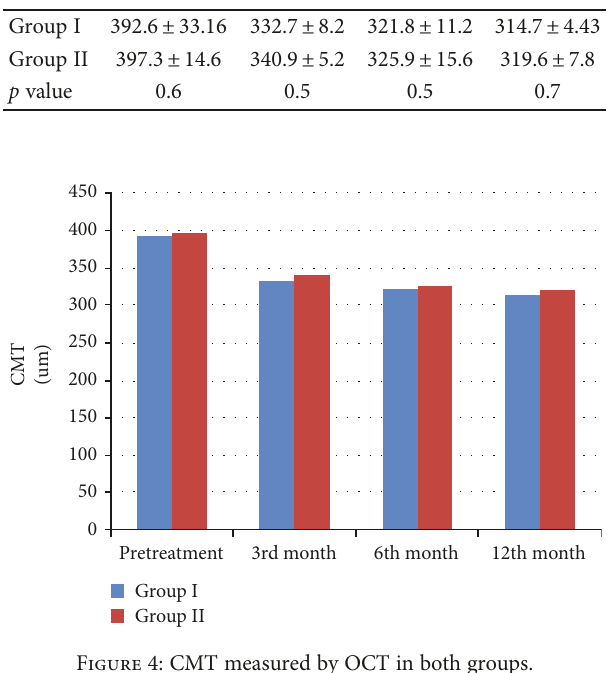
Figure 4: CMT measured by OCT in both groups.